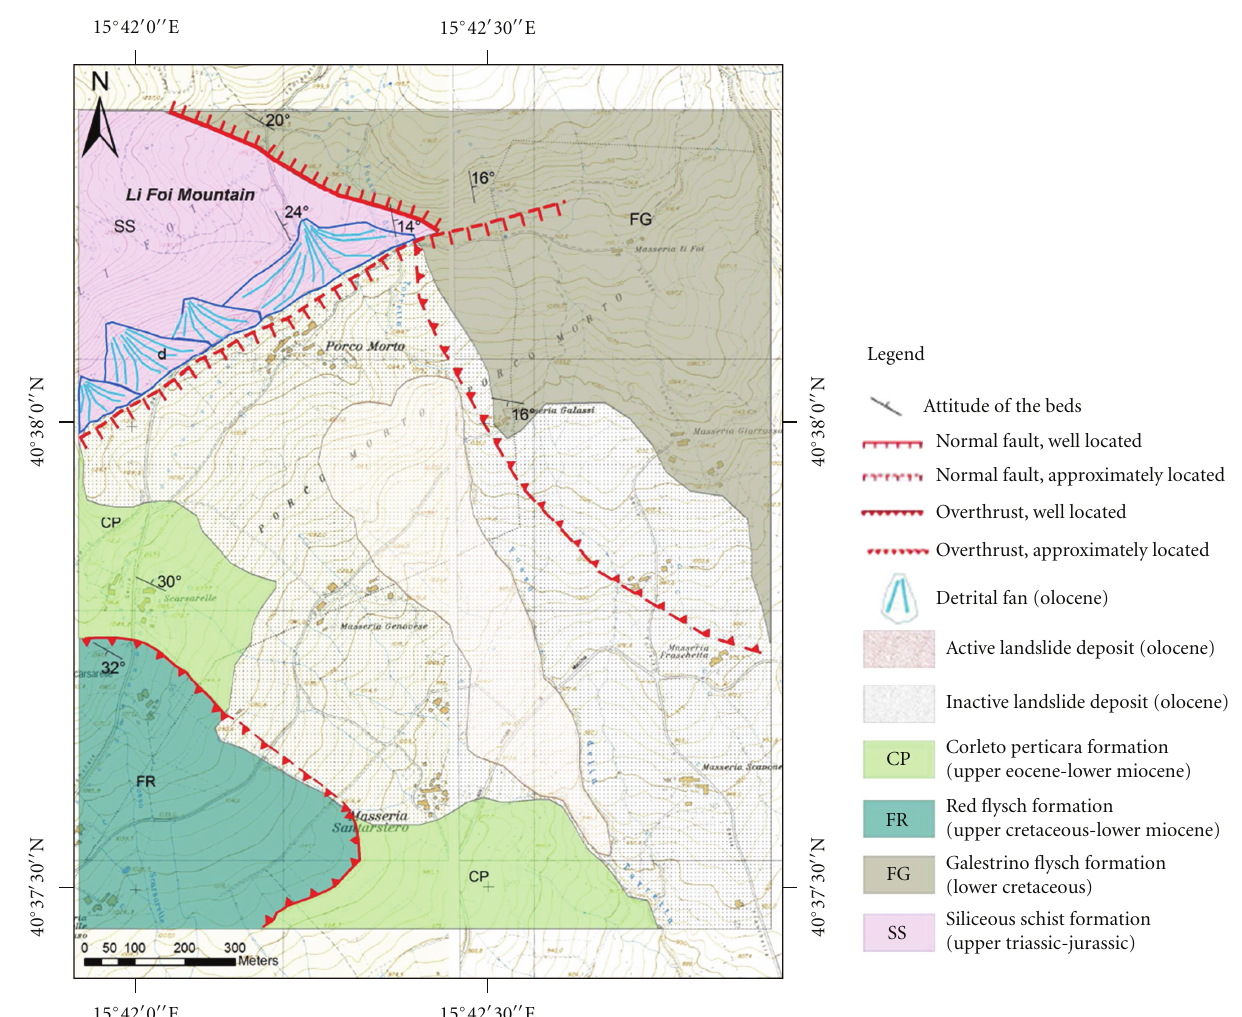
Figure 2: Geologic map of the area (from